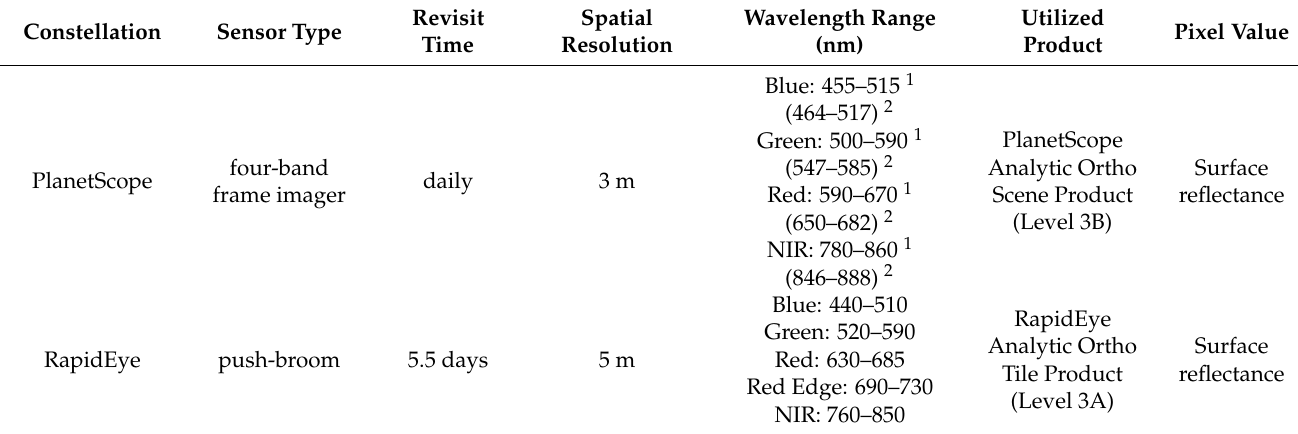
Table 1. Specifications of the RapidEye and PlanetScope sensors and products used in this study. Constellation Sensor